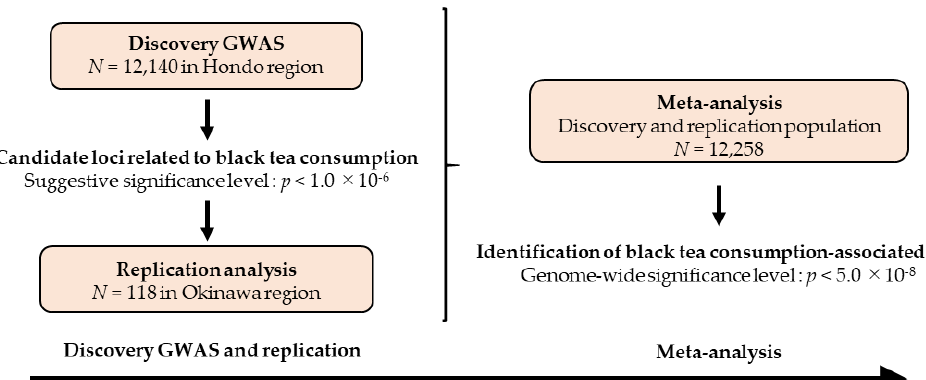
Figure 1. Research flow of the present study. GWAS: Genome-wide association study.